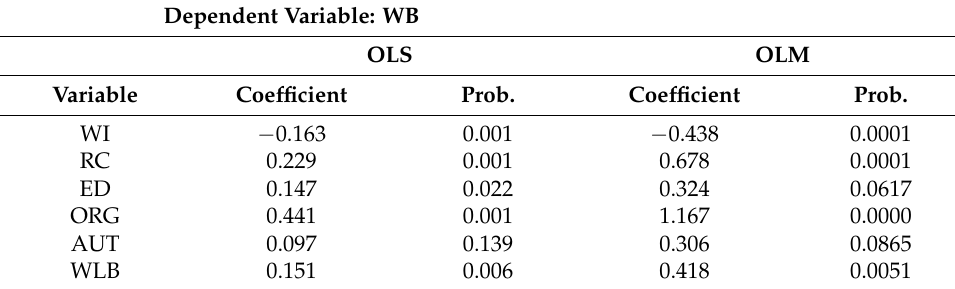
Table 4. Results of the regression—model